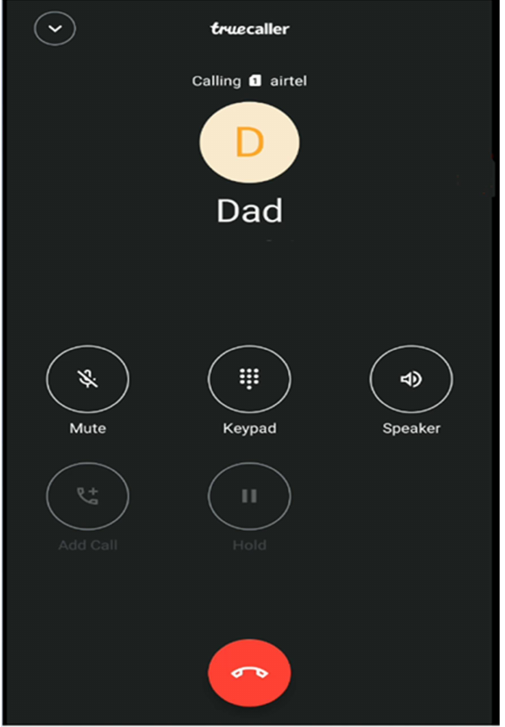
Fig 7 Chatbot performs the required